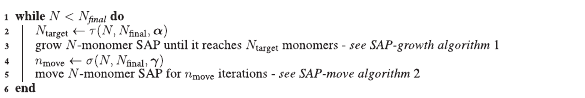
Algorithm 3 | Complete Algorithm For Generating Chromosome Con fi